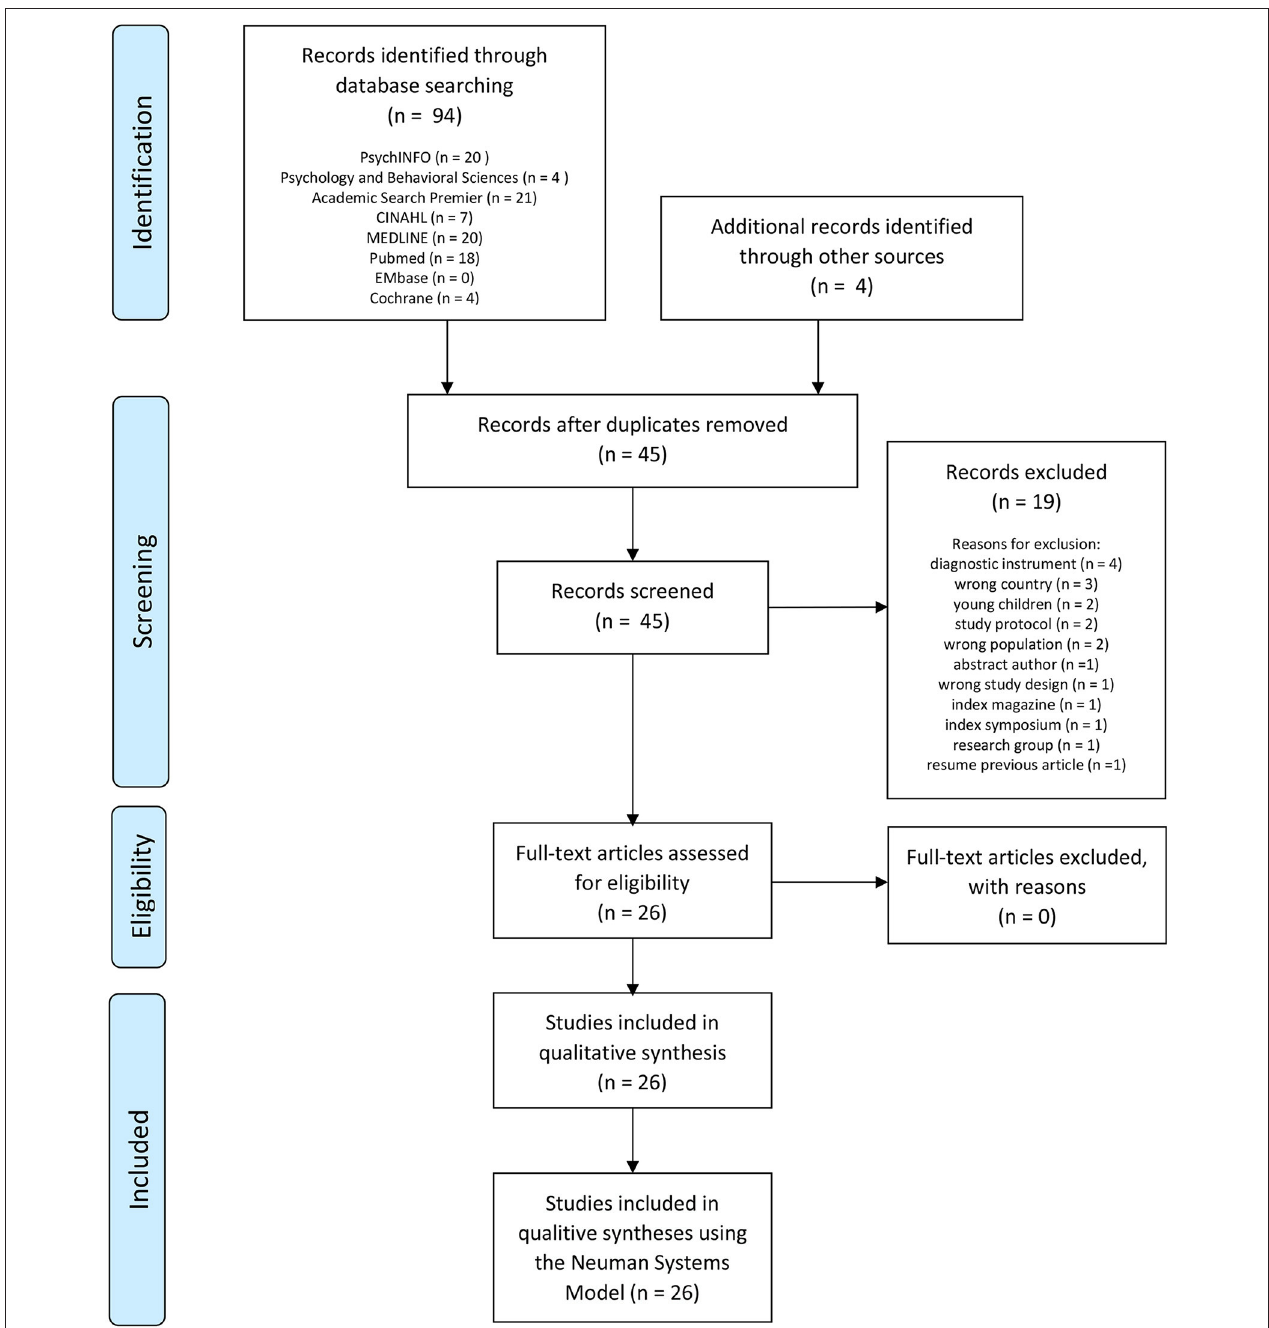
FIGURE 2 | PRISMA flow diagram for the scoping review